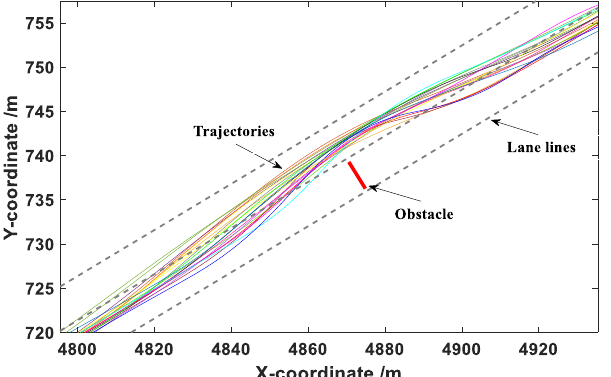
Figure 11. Obstacle avoidance trajectories under a vehicle speed of 80 km/h.